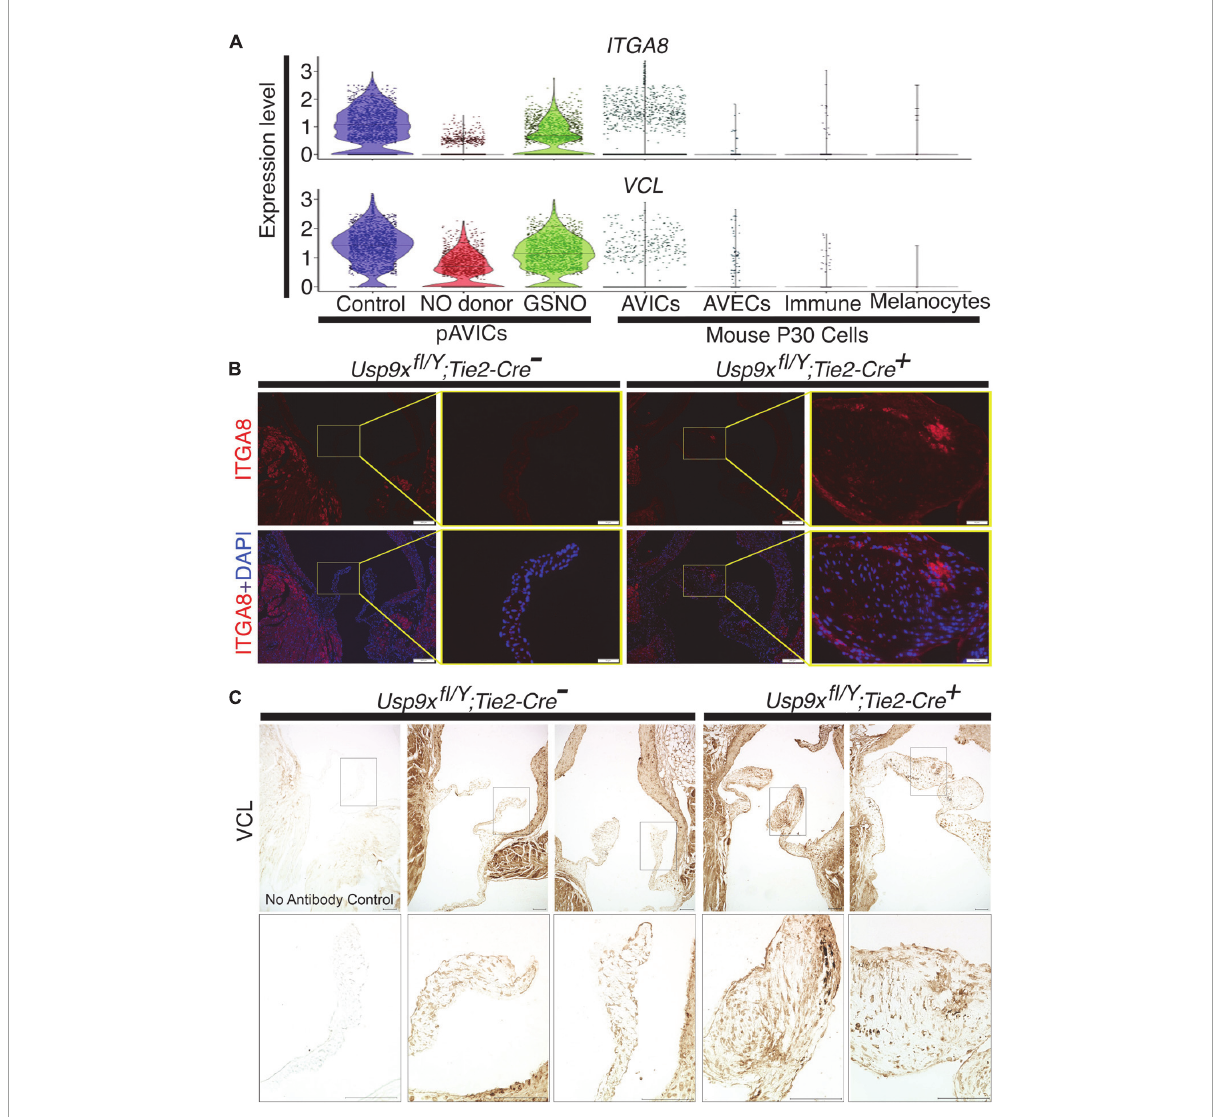
FIGURE3 Increased expression of ITGA8 and vinculin (VCL) in calcified mouse aortic valve. (A) Violin plots demonstrate the expression of ITGA8 and VCL in porcine aortic valve interstitial cells (pAVICs) and mouse P30 aortic valve cells. (B) Immunofluorescence staining of aortic valve sections demonstrates the increase of ITGA8 (Integrin α 8; red) expression in calcific conditions ( Usp9x fl / Y ; Tie2-Cre + ) compared to ( Usp9x fl / Y ; Tie2-Cre - ) controls ( n = 2) and co-stained with nuclear DAPI (blue). Arrows indicate the representative area of expression of ITGA8. Yellow boxes indicate the magnified area of the tissue sections shown right of each image. Scale bar: 100 µ m. (C) Immunohistochemistry of aortic valve sections demonstrate increased expression of VCL in ( Usp9x fl / Y ; Tie2-Cre + ) compared to ( Usp9x fl / Y ; Tie2-Cre - ) controls ( n = 2). Negative control with no primary antibody is shown in the first column. Boxes indicate the magnified area of tissue sections shown below each image. Scale bar: 100 µ